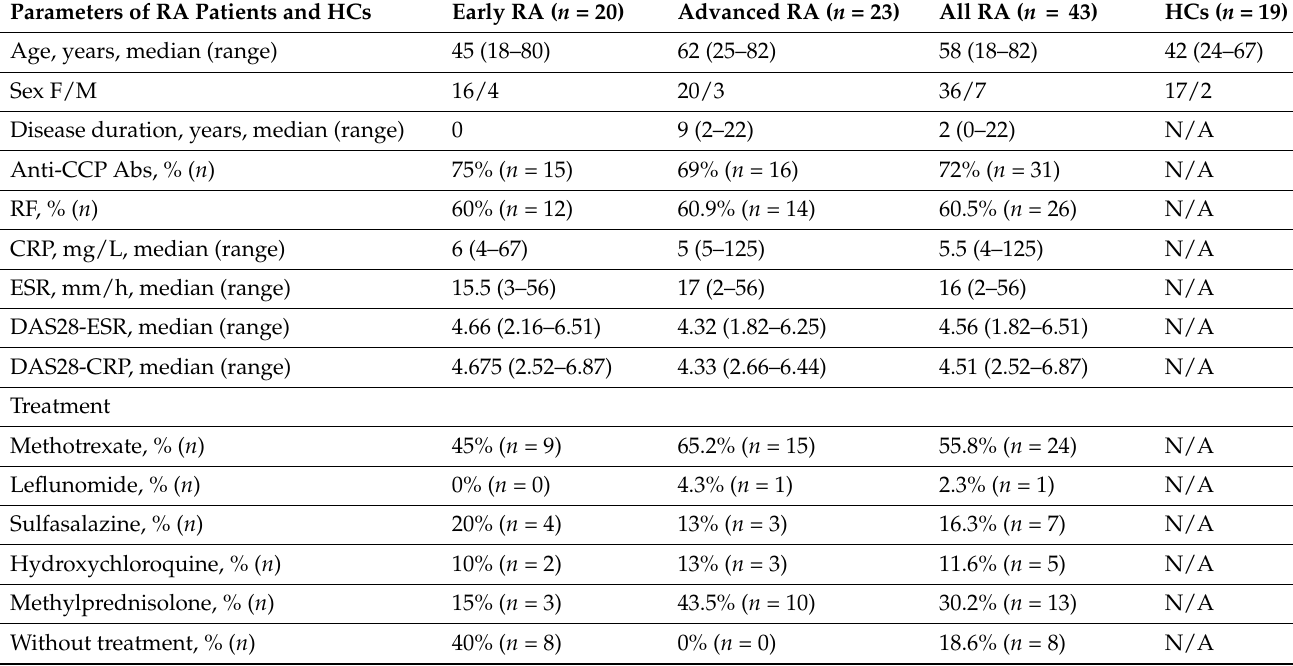
Table 1. Clinical and laboratory data of RA